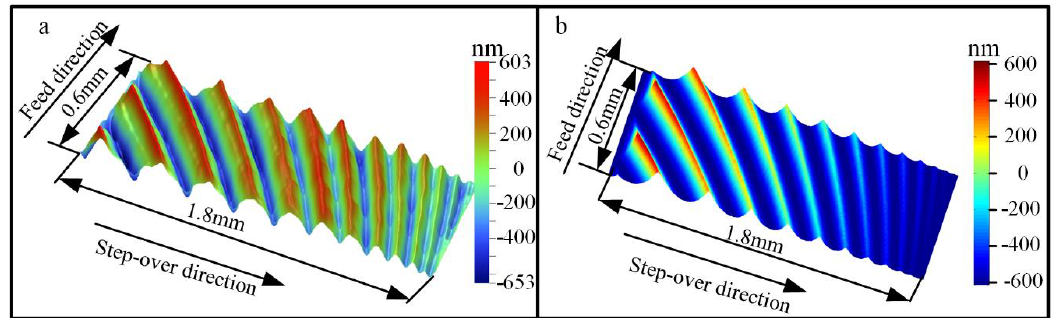
Figure 2. The comparison result indicates that the experimental and simulated surface topography show great consistency.